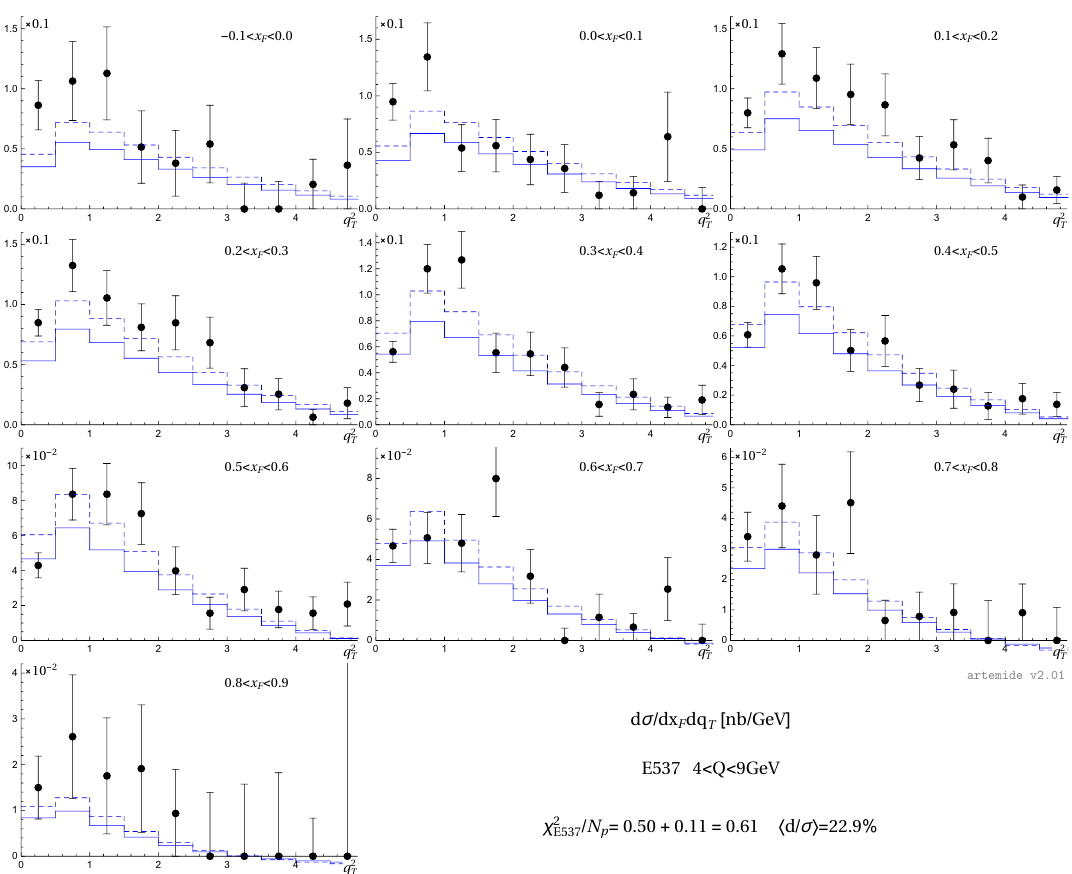
Figure 2 . Comparison of the theory prediction (solid line) to E537 di(cid:11)erential in x F . The dashed line is the theoretical prediction after the addition of systematic shifts d i . The values of the (cid:31) 2 and d i are calculated for the full set of data with 8% correlated error. (cid:12)gure 6 the visual comparison of the theory to NA3 is shown. The plots for Q -di(cid:11)erential bins made for the range of q larger than it is allowed by the TMD factorization (the T boundary q ’ 0 : 25 Q is shown by the vertical dashed line). It is interesting to observe T that the TMD factorization formula works unexpectedly well outside of this